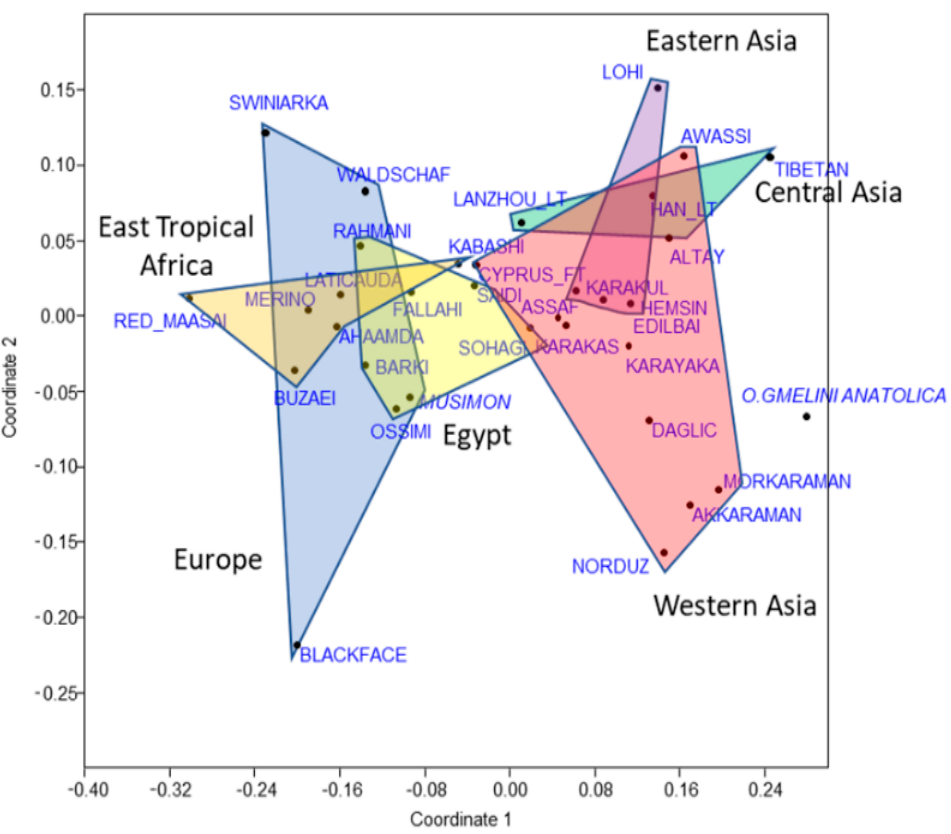
Figure 1. The NMDS position of the breeds based on their F st. The envelopes gathering the domestic Ovis aries breeds were drawn according to the six regions defined in Table 1. The Asian Mouflon Ovis gmelini anatolica was treated separately.